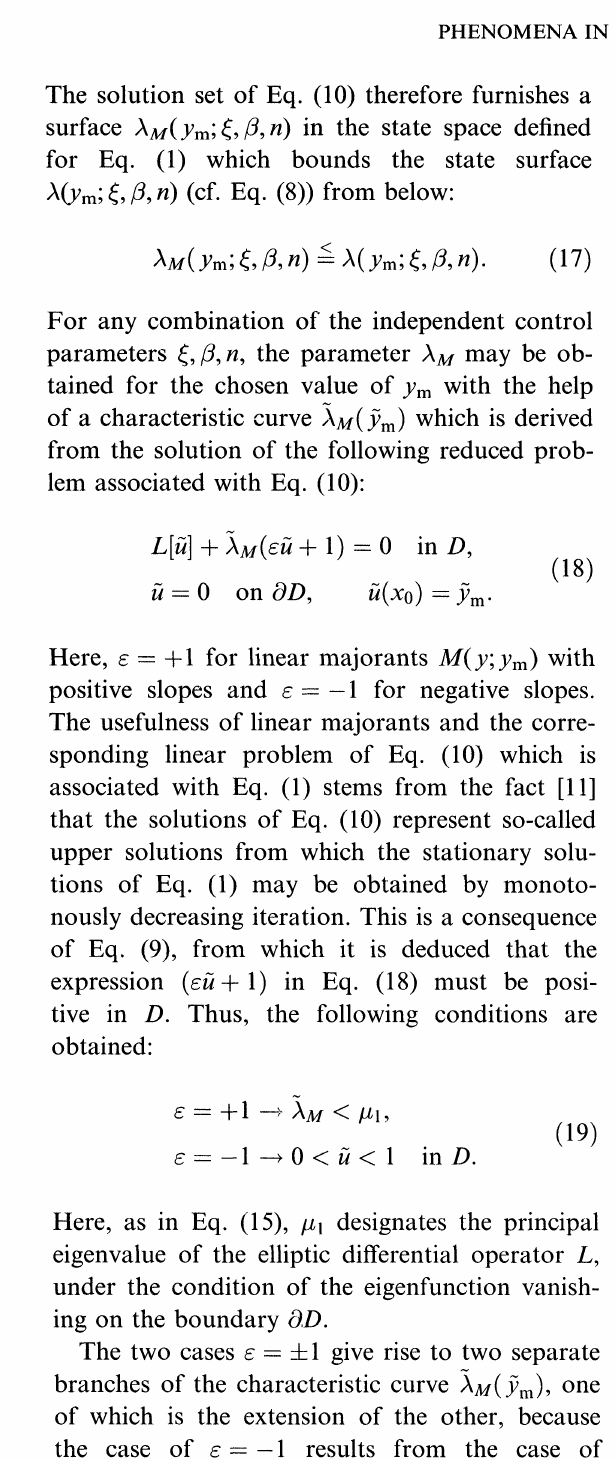
The characteristic curve for the reduced problem given by Eq.